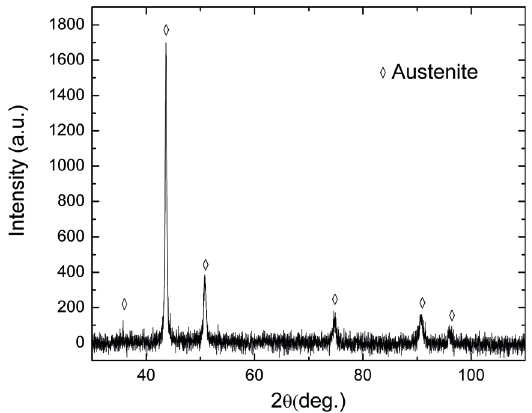
Figure 1. X-ray diffractogram of the AISI 304L sample.